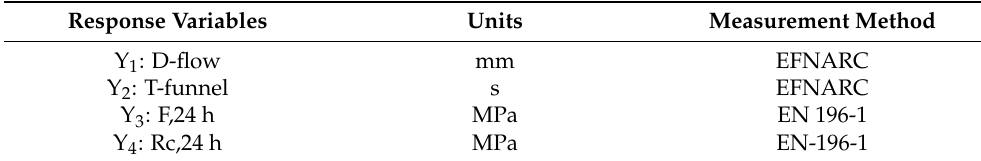
Table 2. Response variable